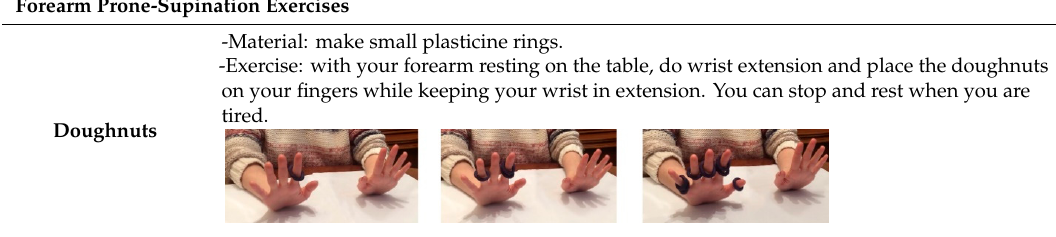
Forearm Prone-Supination Exercises